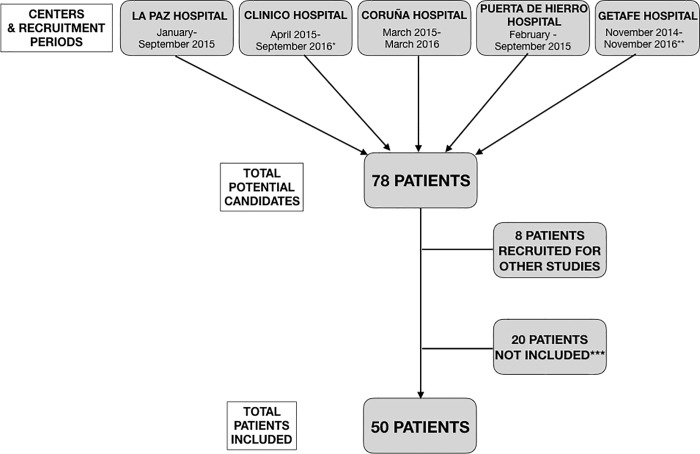
Flow chart showing the patient recruitment.Recruiting centers and recruitment periods are shown on the top row. Recruitment periods vary between hospitals due the existence of other studies recruiting the same type of patients. *One other study also aimed to recruit the same type of patients during this period. **During this two year period there were some interruptions in the recruitment due to circumstances not related with the study. ***It includes patients that did not meet inclusion criteria (3) and patients whose parents denied participation (11).